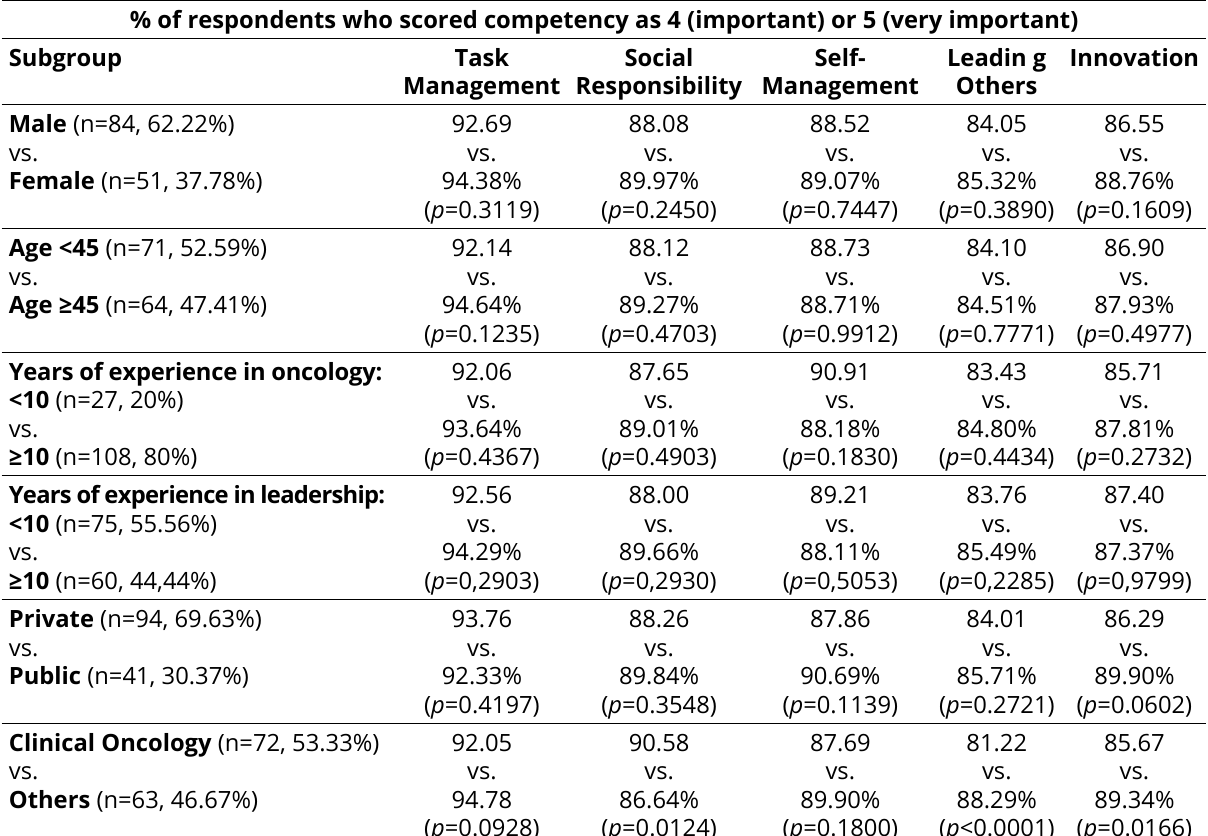
Table 3. Subgroup analyses of the Brazilian participants. % of respondents who scored competency as 4 (important) or 5 (very